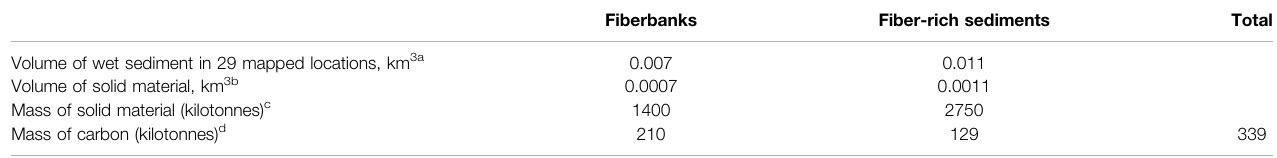
TABLE 3 | Estimate of carbon stored in fi ber banks and fi ber-rich sediments of 29 mapped locations in the Swedish coastal zone (Norrlin and Josefsson,